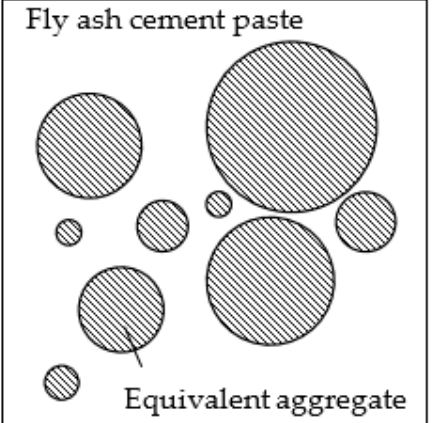
Figure 4. Two-phase fly ash concrete composed of fly ash cement paste and equivalent aggregates.